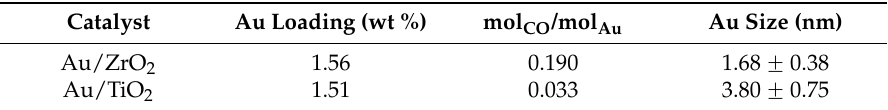
Table 2. Examined